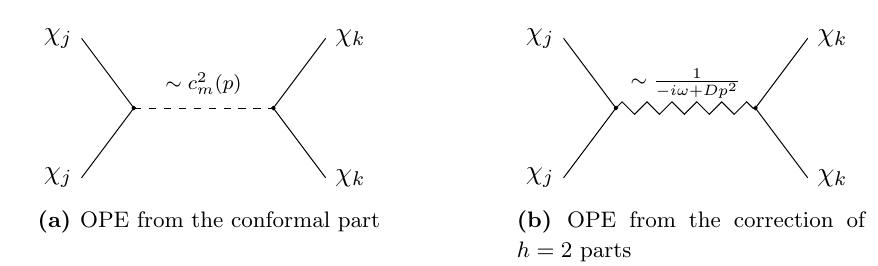
Figure 6. (a) The conformal limit of the four-point function corresponds to collective (cid:12)elds that are locally critical and short-range correlated in space (see equation (4.6)). (b) The non-conformal corrections of the four-point function corresponds to the reparameterization (cid:12)eld, which has a di(cid:11)usive dynamics in